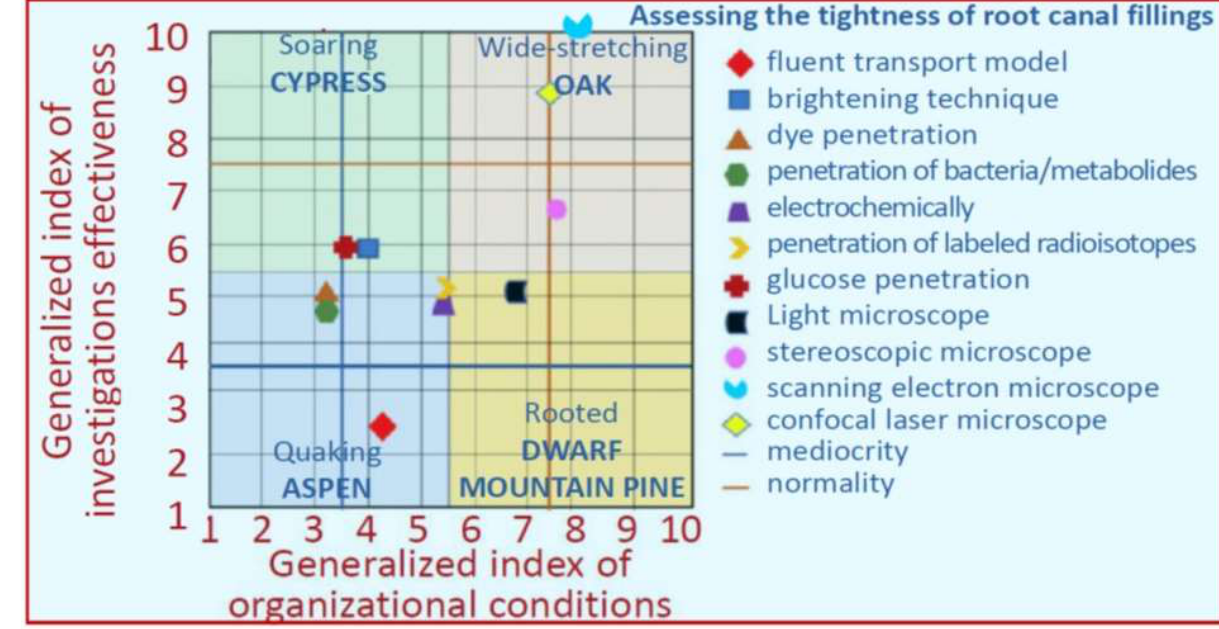
Figure 12. Matrix of attractiveness for the assessment of tightness of root canal fillings. Measurements of the width of the gaps between the root canal wall and the filling